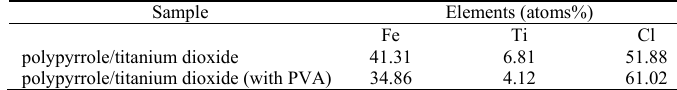
Table 1: EDX analysis data of polypyrrole/titanium dioxide with and without stabilizer